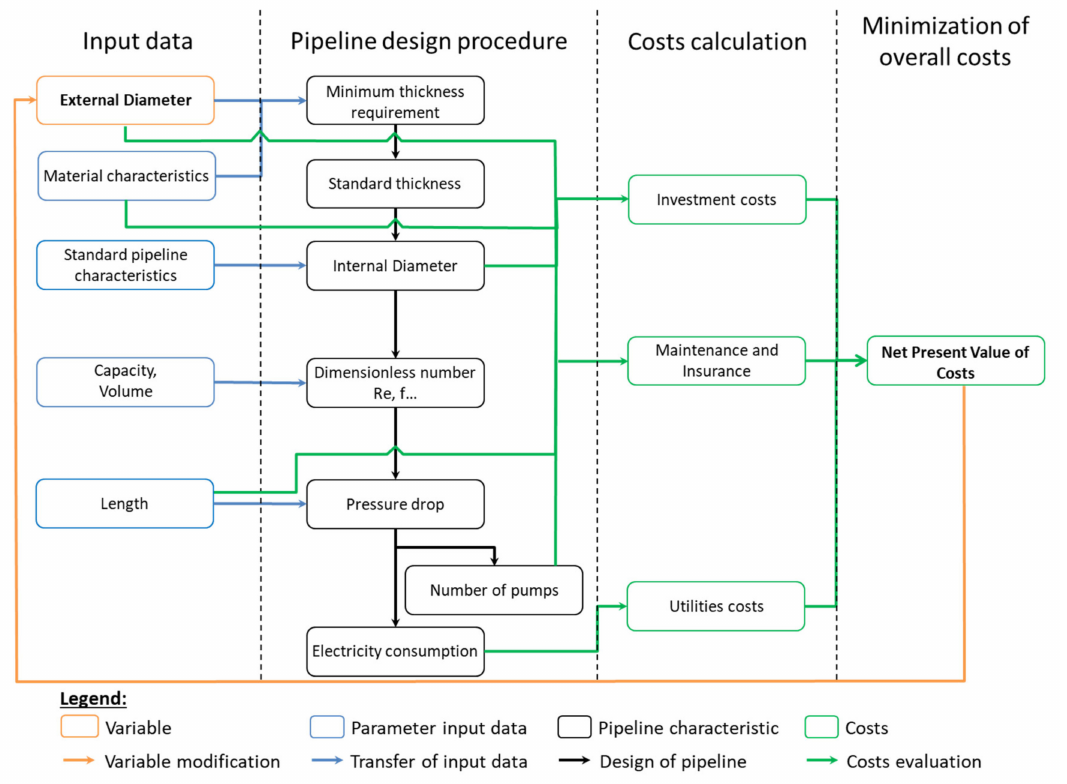
Figure A1. Pipeline design